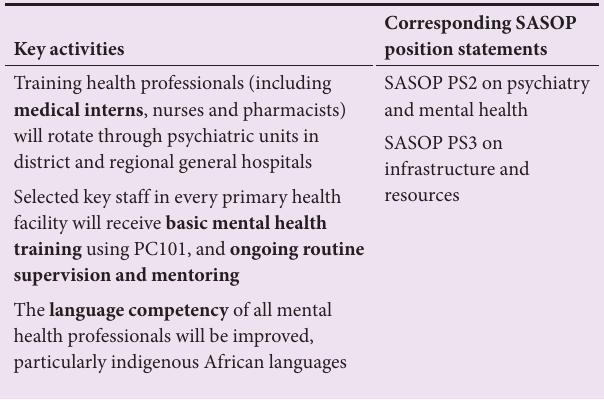
Table 7. Objective 7: Human resources for mental health